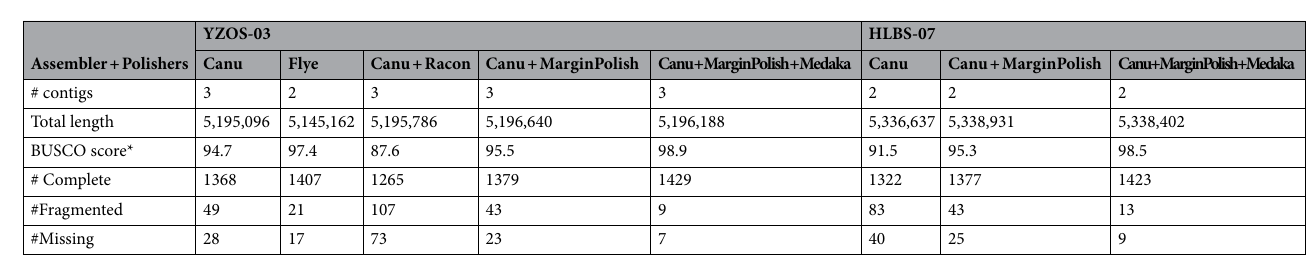
Table 1. Comparison of BUSCO completeness of genome assemblies. *Results from dataset